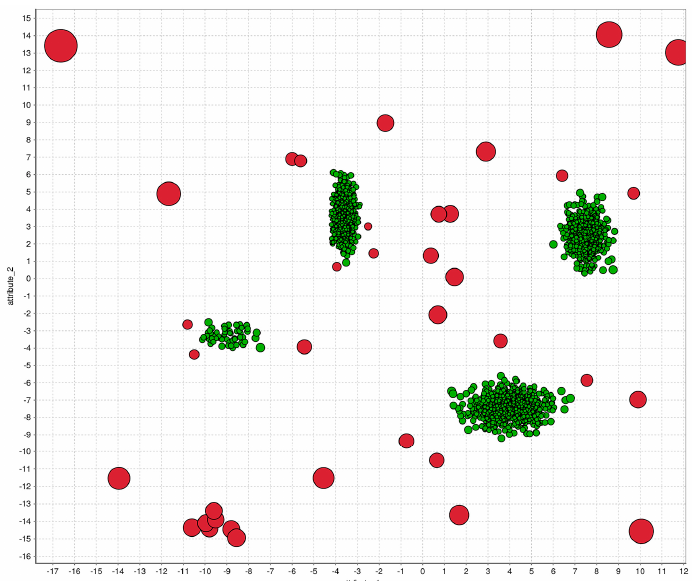
Figure 4 . Anomaly recognition in data . Figure 4. Anomaly recognition in